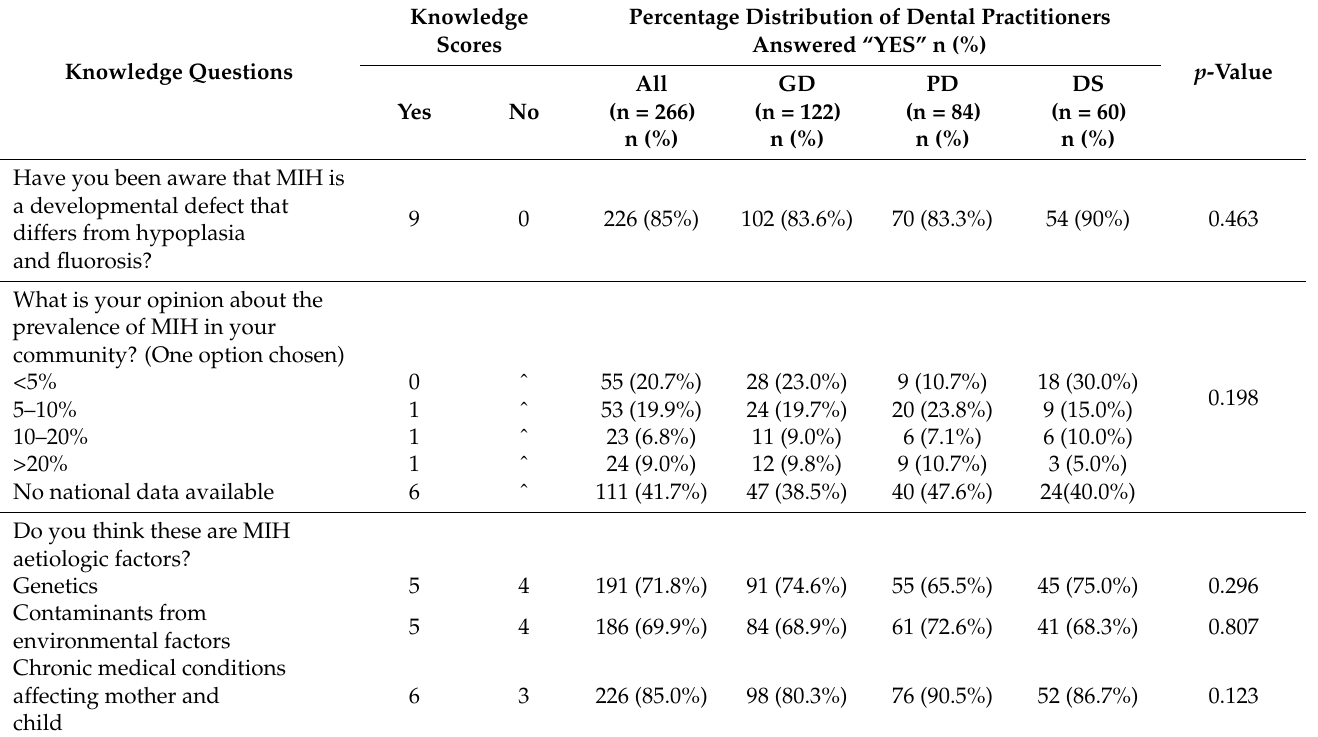
Table 2. Percentage distribution of MIH knowledge scores of general practitioners (GD),